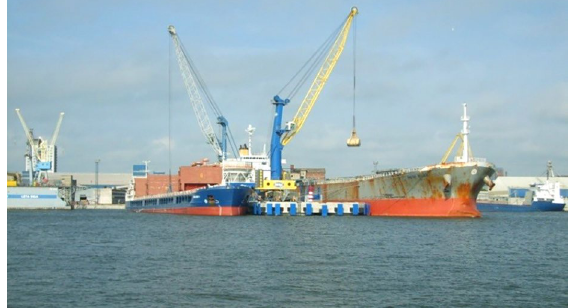
Fig.18. Bulk ship MEDI KOBE moored to the jetty (quay wall 67A) at the port of